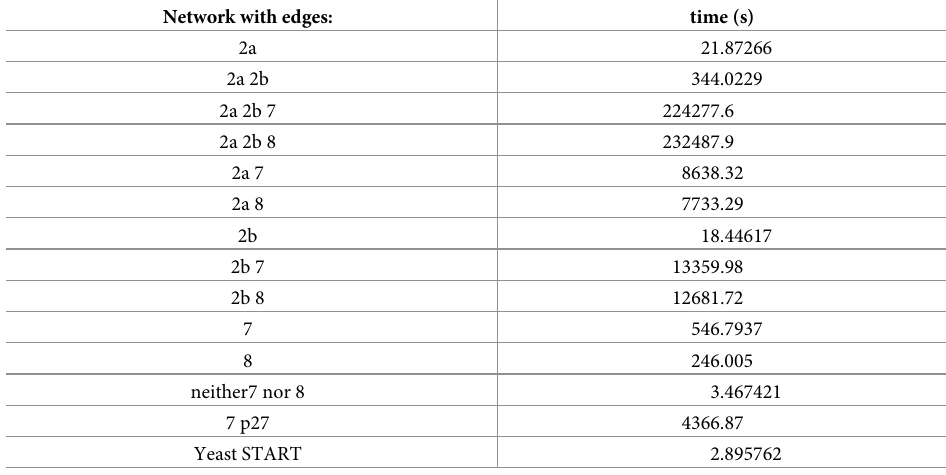
Table 1. Computational time. CPU time to compute all four resettable bistability and hysteresis queries for various networks. Network with